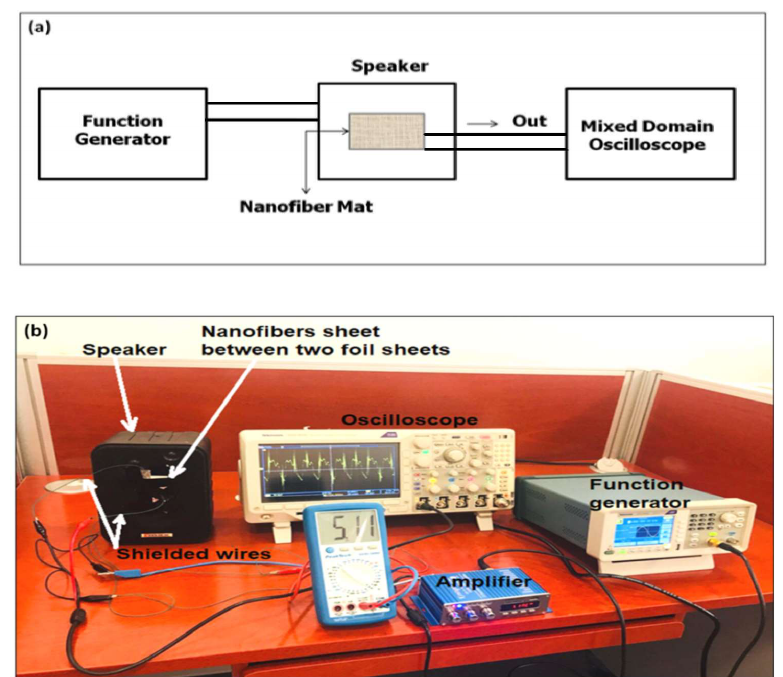
Figure 1. ( a ) Schematic diagram of the acoustic energy harvesting setup. ( b ) A photo of the detailed acoustic sensing setup.